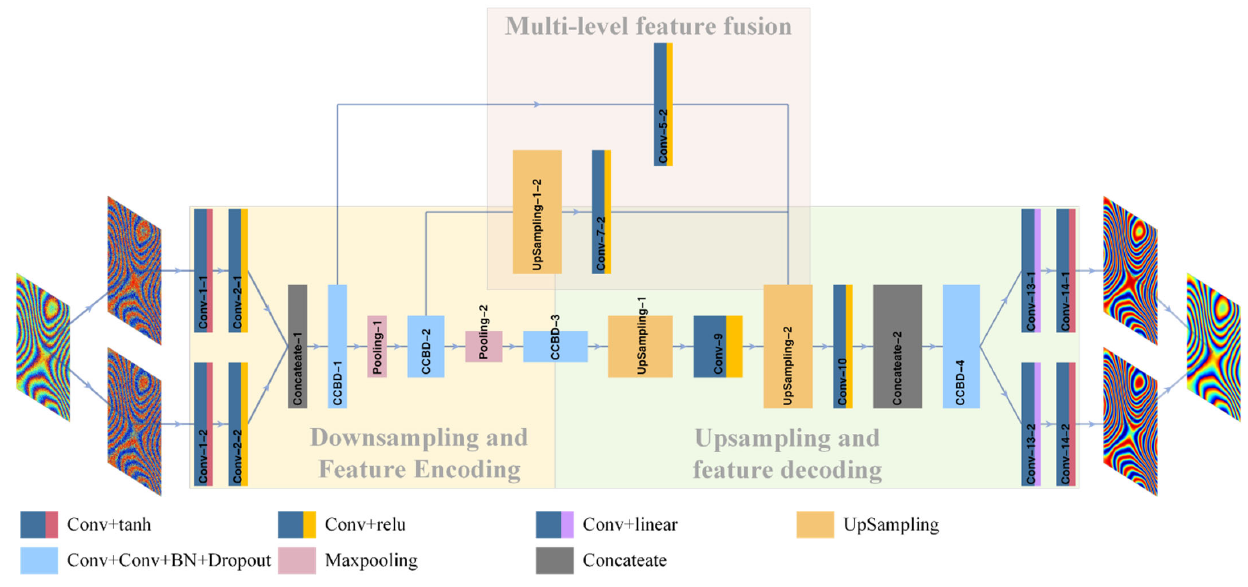
Figure 1. Proposed network model architecture.